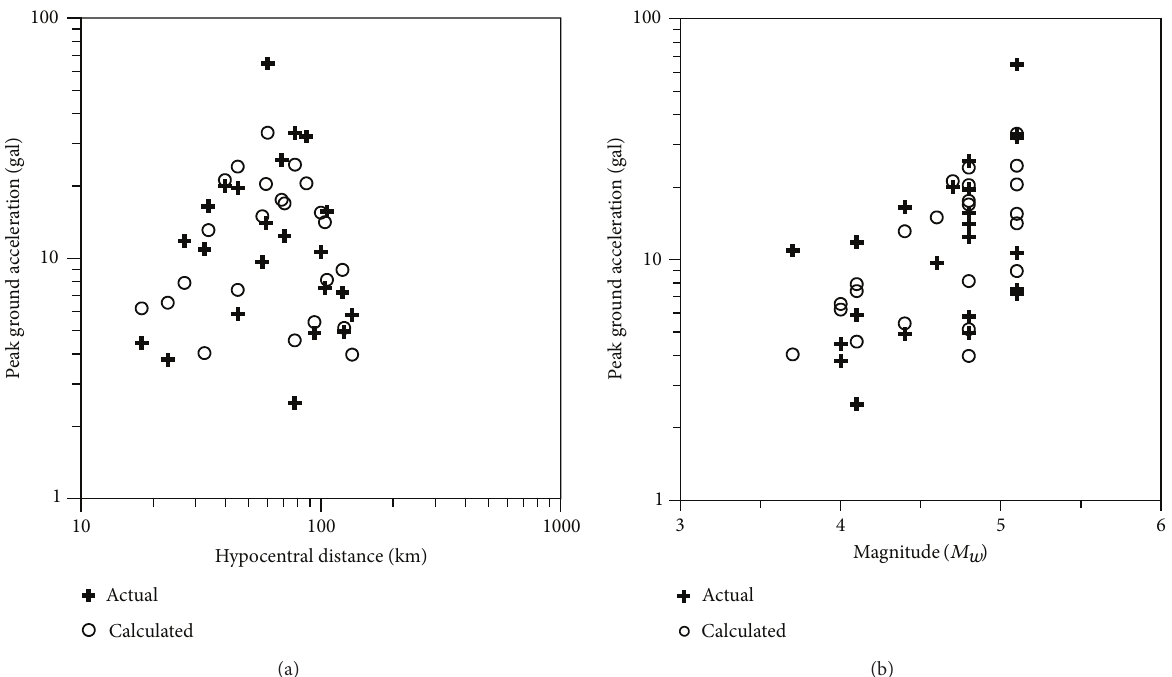
Figure 5: Comparison of observed peak ground acceleration with calculated for the Garhwal Himalaya